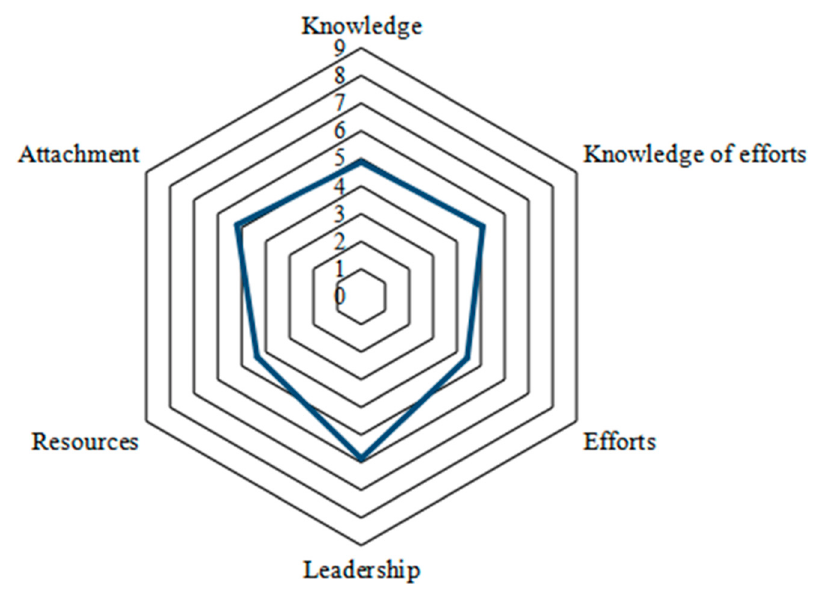
Figure 2. Community capability level of each dimension.